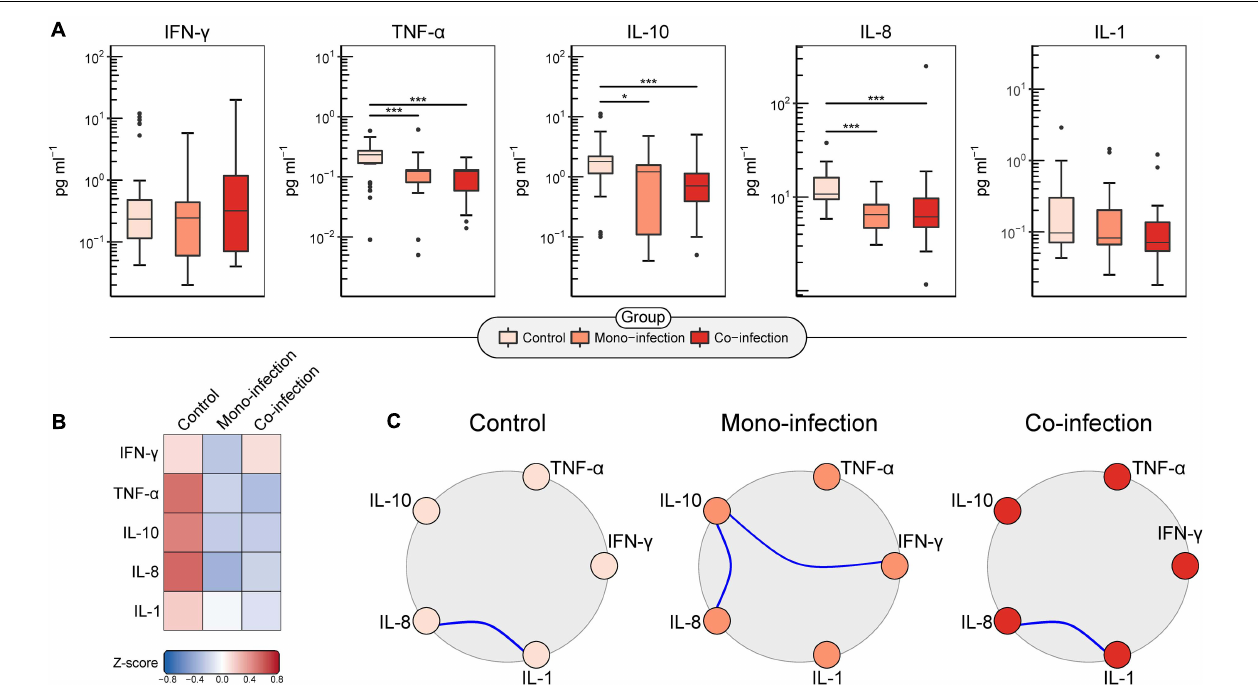
FIGURE 2 | Analysis of cytokine expression among the compared groups. (A) Boxplots of serum levels (pg/mL) of log10-transformed IFN- γ , TNF, IL-10, IL-8, and IL-1 cytokines. * p < 0.05, *** p < 0.001 (Kruskal–Wallis with Dunn’s post-test and Holm’s correction for P -value adjustment). (B) Heatmap generated from Z -scores calculated across groups illustrates differences in cytokine profiles among the compared groups. (C) Cytokine networks constructed using Pearson’s correlation coefficient depict pairwise relationships between cytokine expression levels. Blue-colored links between nodes represent statistically significant positive